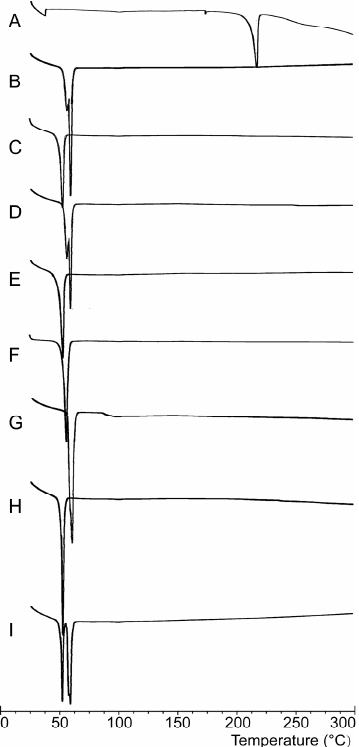
Figure 2. Differential scanning calorimetry (DSC) thermograms of PPD ( A ), Polyethylene glycol 6000 (PEG6000) ( B ), Poloxamer 188 (F68) ( C ), Formulation 1 (F1) ( D ), Formulation 2 (F2) ( E ), Formulation 3 (F3) ( F ), Physical mixture with PEG6000 (PEG6000 PM)( G ), Physical mixture with F68 (F68 PM) ( H ), Physical mixture with PEG6000 and F68 (PEG6000 and F68 PM) ( I ).